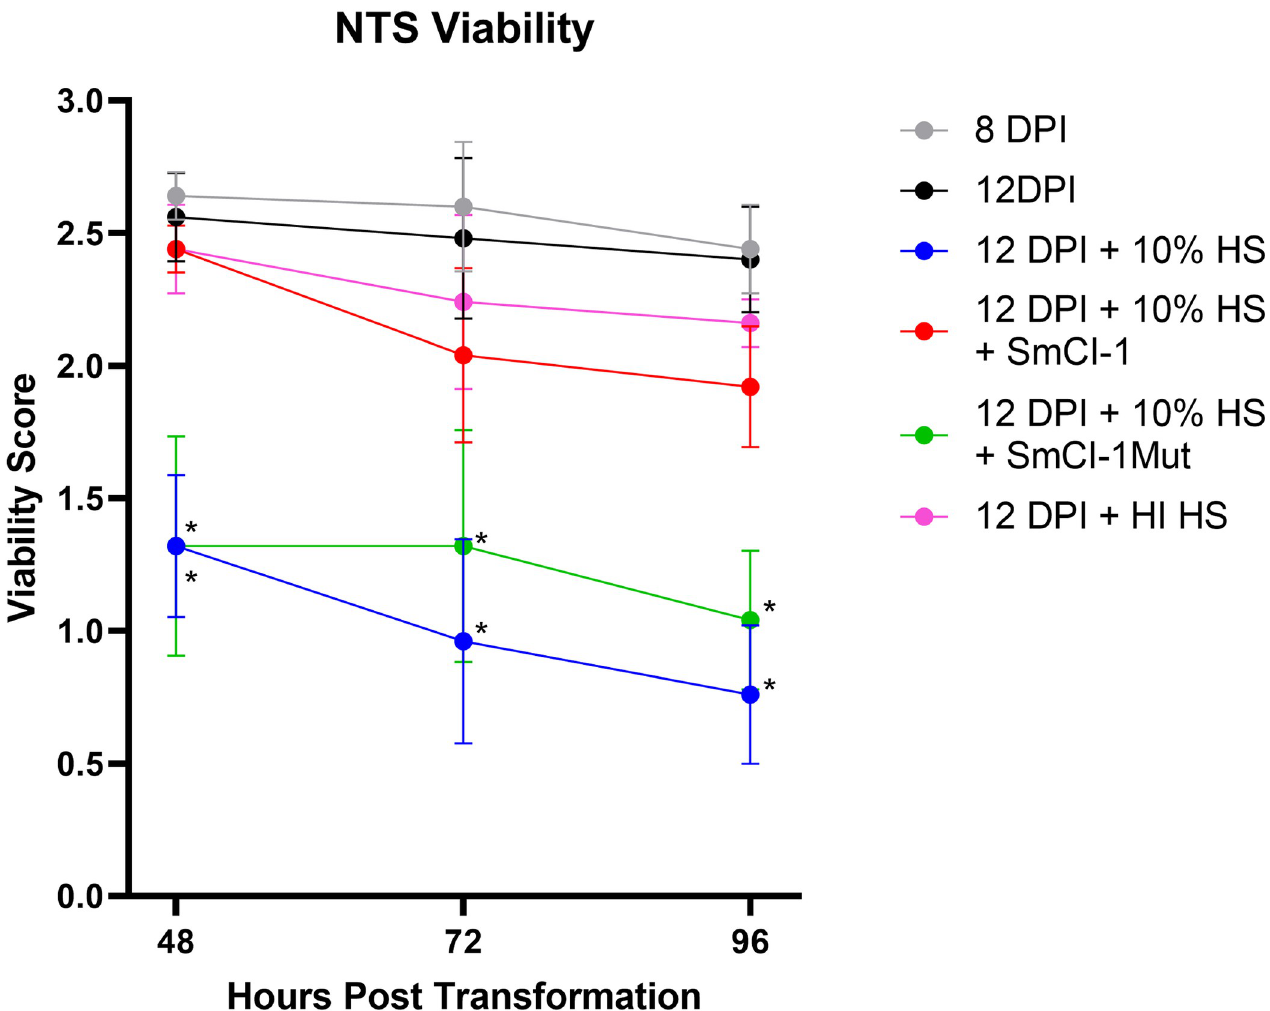
Fig 5. SmCI-1 KD schistosomula are more susceptible to plasma mediated killing Viability scores of SmCI-1 KD (8dpi) and SmCI-1 KD (12dpi) schistosomula at 2, 3 and 4 days post transformation. Newly transformed schistosomula were treated with human serum (HS), and either the wild type rSmCI-1, or the catalytically inactive mutant rSmCI-1Mut. Parasites were alternatively treated with heat inactivated human serum (HIHS). ( � ) indicates where treatments differed significantly from SmCI-1 KD schistosomula exposed to 10% human serum and wild type rSmCI-1. (n =